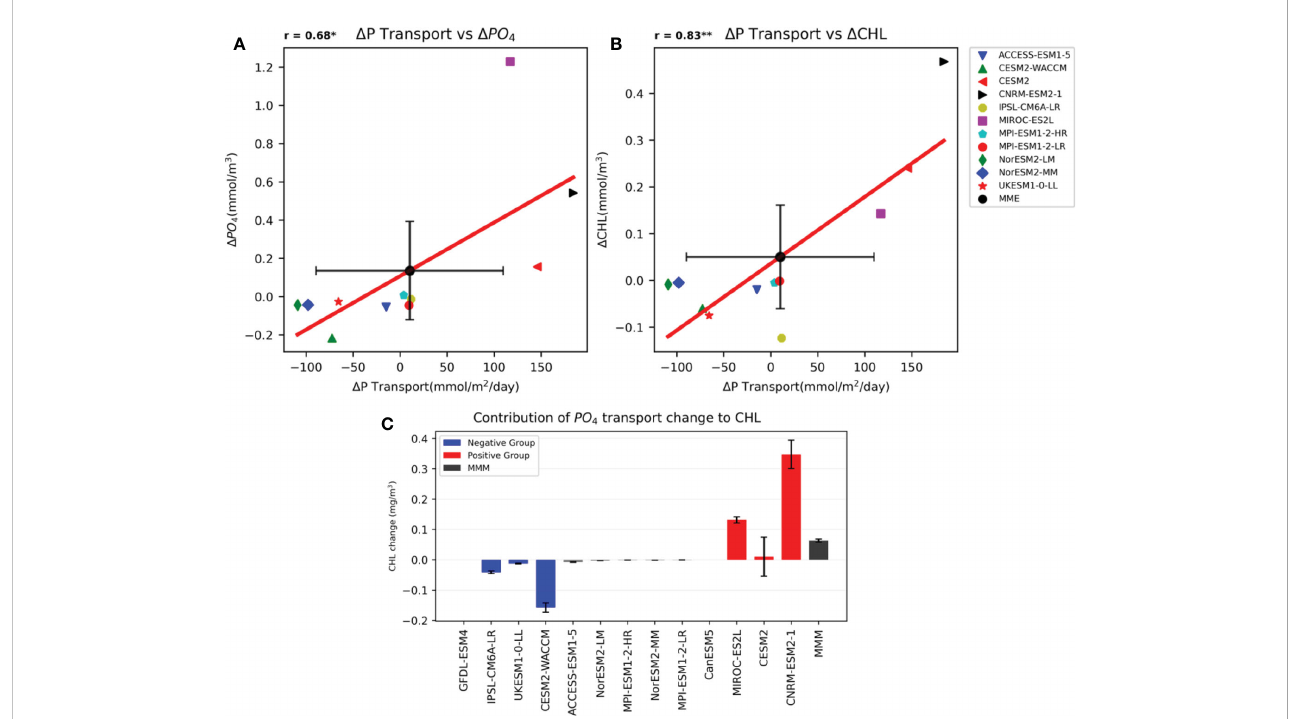
FIGURE 4 (A) Correlation coef fi cient of 11 CMIP6 models for the surface DIP concentration and meridional PO 4 transport index of the YECS region. (B) Same as Figure 4A, showing the correlation between 11 CMIP6 models in terms of SCHL concentration and meridional PO 4 transport index for the YECS region. Black dots and crosses represent the MMM of 11 models and spread (±1std). (C) Contribution of PO 4 transport change to SCHL of 11 CMIP6 models. Black bar indicates the MMM of 11 models and crosses represent signi fi cance at the 95% con fi dence level. The order of the graph is aligned the same as that of the future change of the SCHL concentration. * mark indicates that the correlation coef fi cient is signi fi cant at the 95% con fi dence level. ** mark indicates that the correlation coef fi cient is signi fi cant at the 99% con fi dence